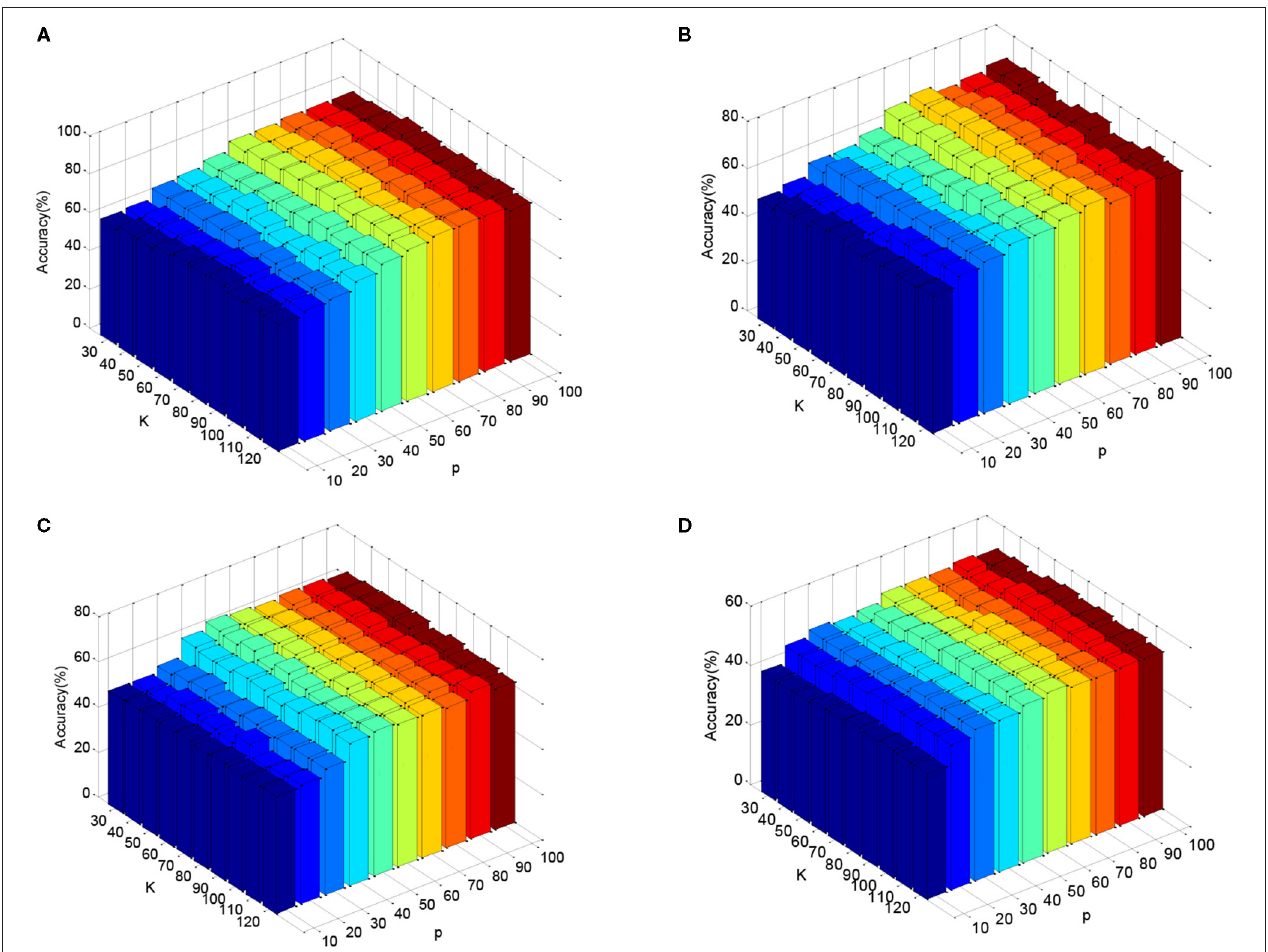
FIGURE 5 | Cross-subject accuracy on DEAP dataset with different parameters p and K using features: (A) PSD, (B) FD, (C) DE, (D) MAV.